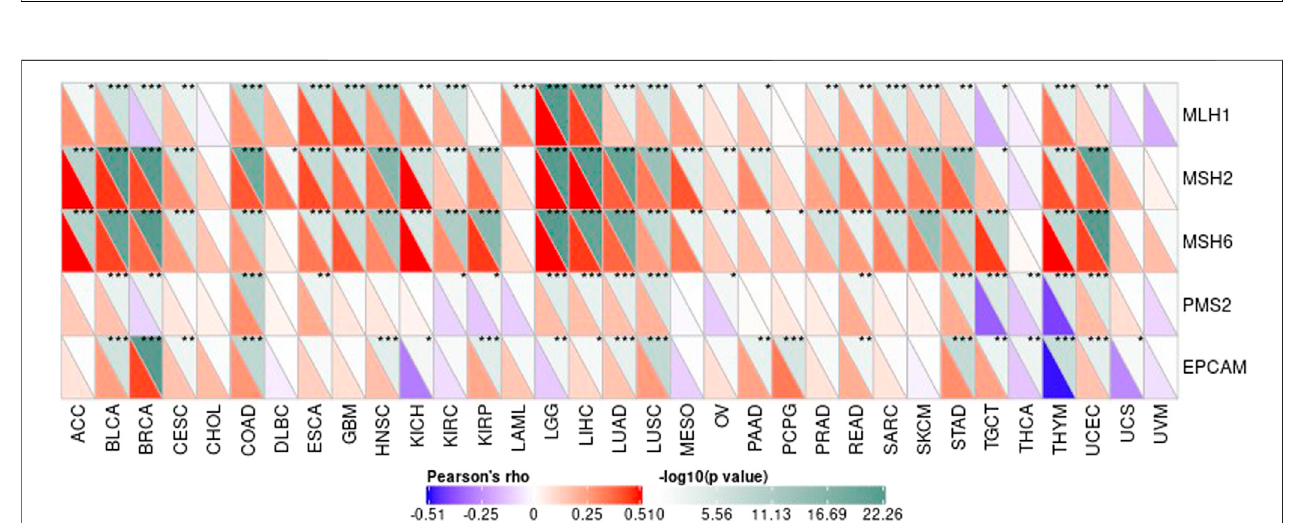
FIGURE 13 | The association between value of genes and the expression of four